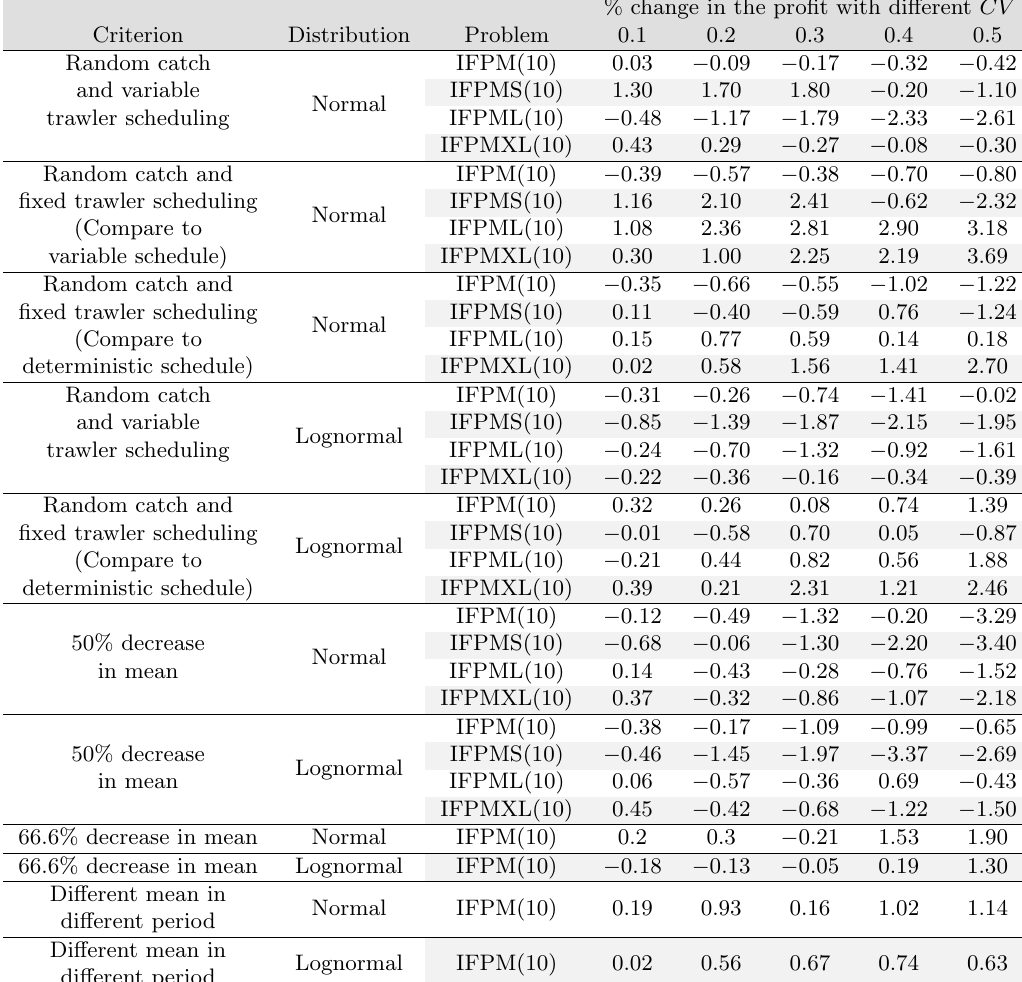
Table 15: Summary of the percentage solution gap in different problems with different experi-